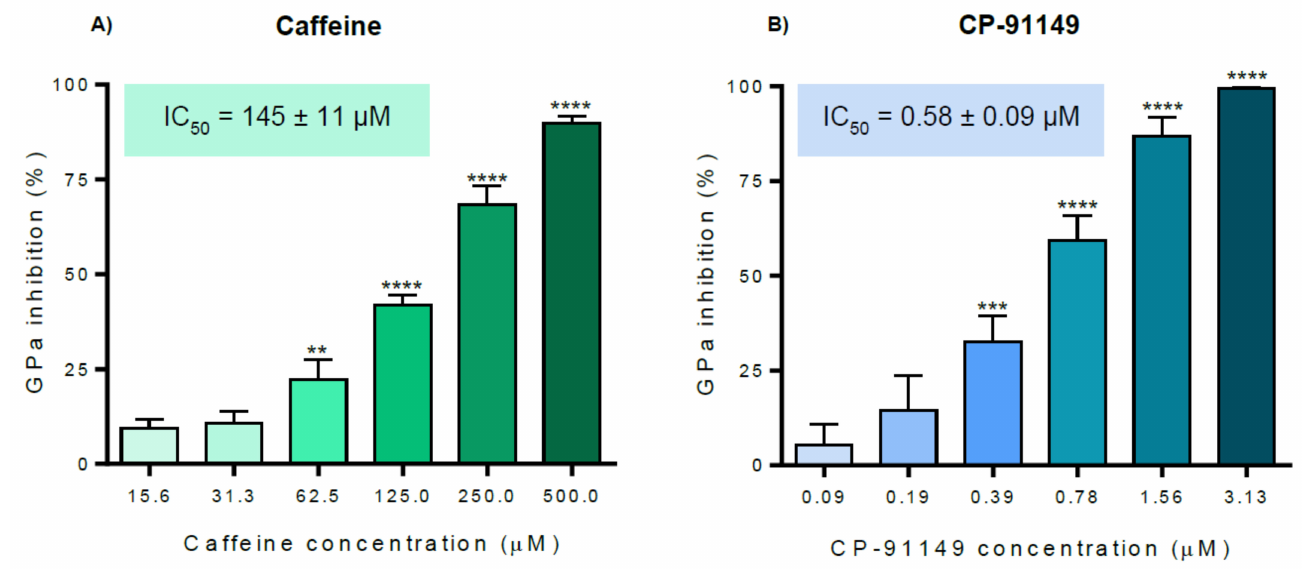
Figure 9. In vitro inhibitory activity of known GP inhibitors, ( A ) caffeine and ( B ) CP-91149, against rabbit muscle GPa. The results are expressed as mean of the percentage of inhibition ± SEM and represent at least four experiments. ** p < 0.01; *** p < 0.001; **** p < 0.0001 when compared with the control (with enzyme and without the compounds under